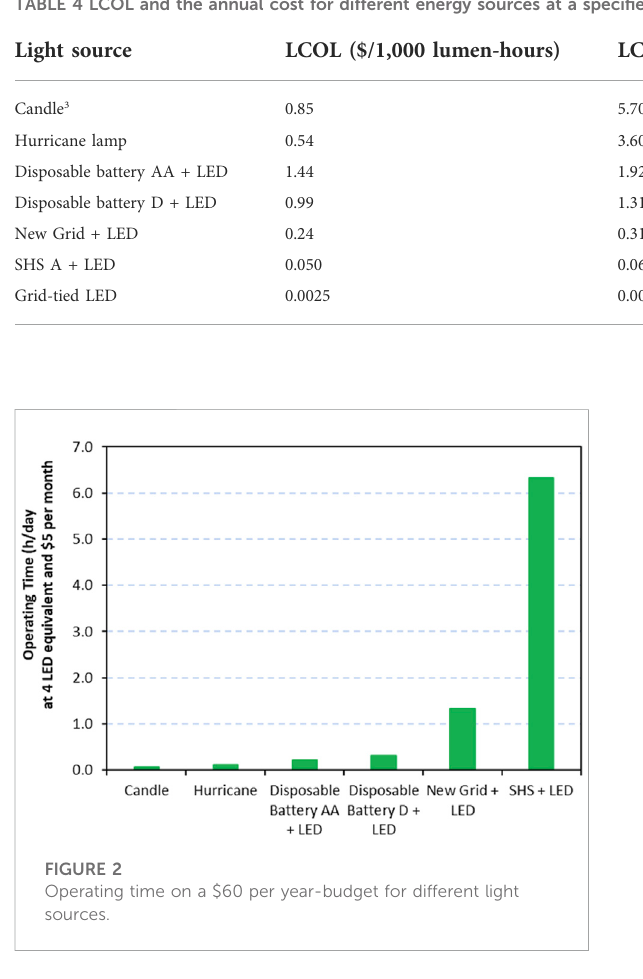
TABLE 4 LCOL and the annual cost for different energy sources at a speci fi ed light output (569,400 lux-hours).